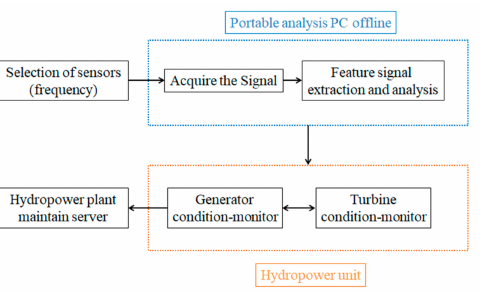
Figure 1. Structure of cavitation erosion monitoring system based on ultrasonic